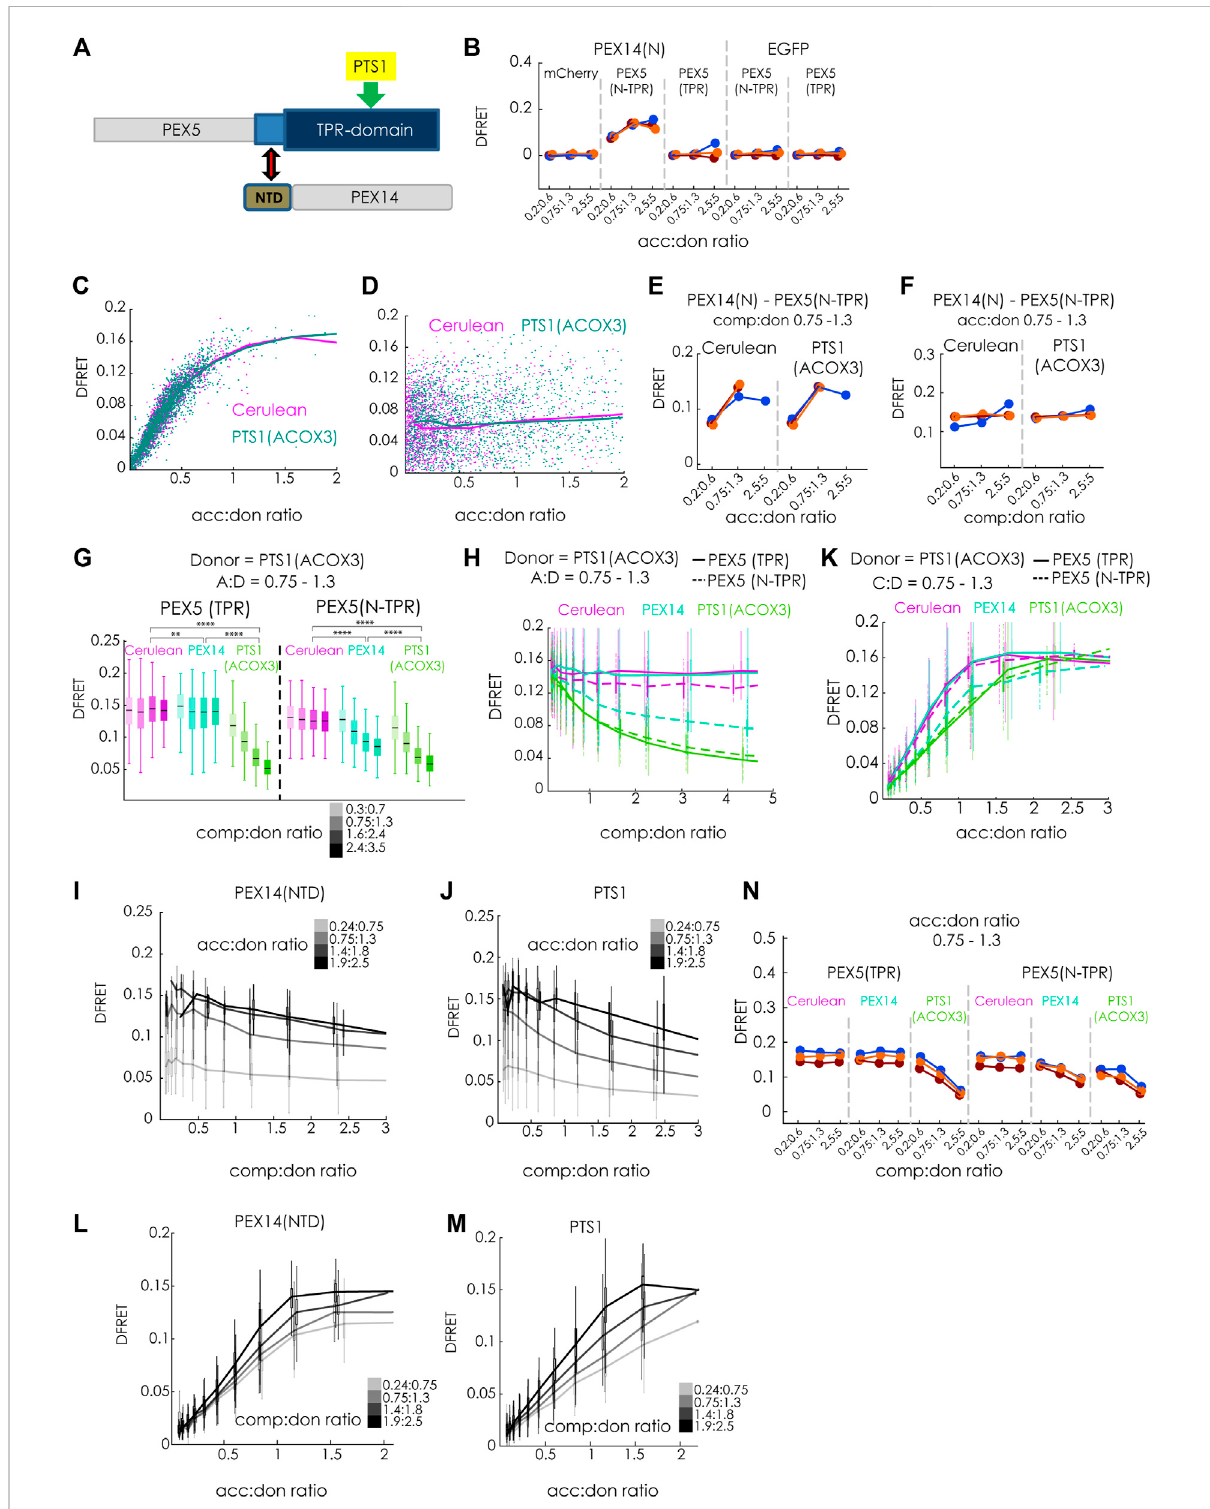
FIGURE 7 The N-terminal domain of PEX14 modulates the af fi nity of PEX5 and its cargo by a non-competitive mechanism: (A) Scheme: the interaction between the TPR-domain of PEX5 (blue) and the PTS1 (yellow) is modulated by the N-terminal domain (NTD, brown) of PEX14, binding to an N-terminal extension of the TPR-domain (bright blue); grey: parts of PEX5 and PEX14 not encoded in the test proteins; (B) bimolecular fl owFRET